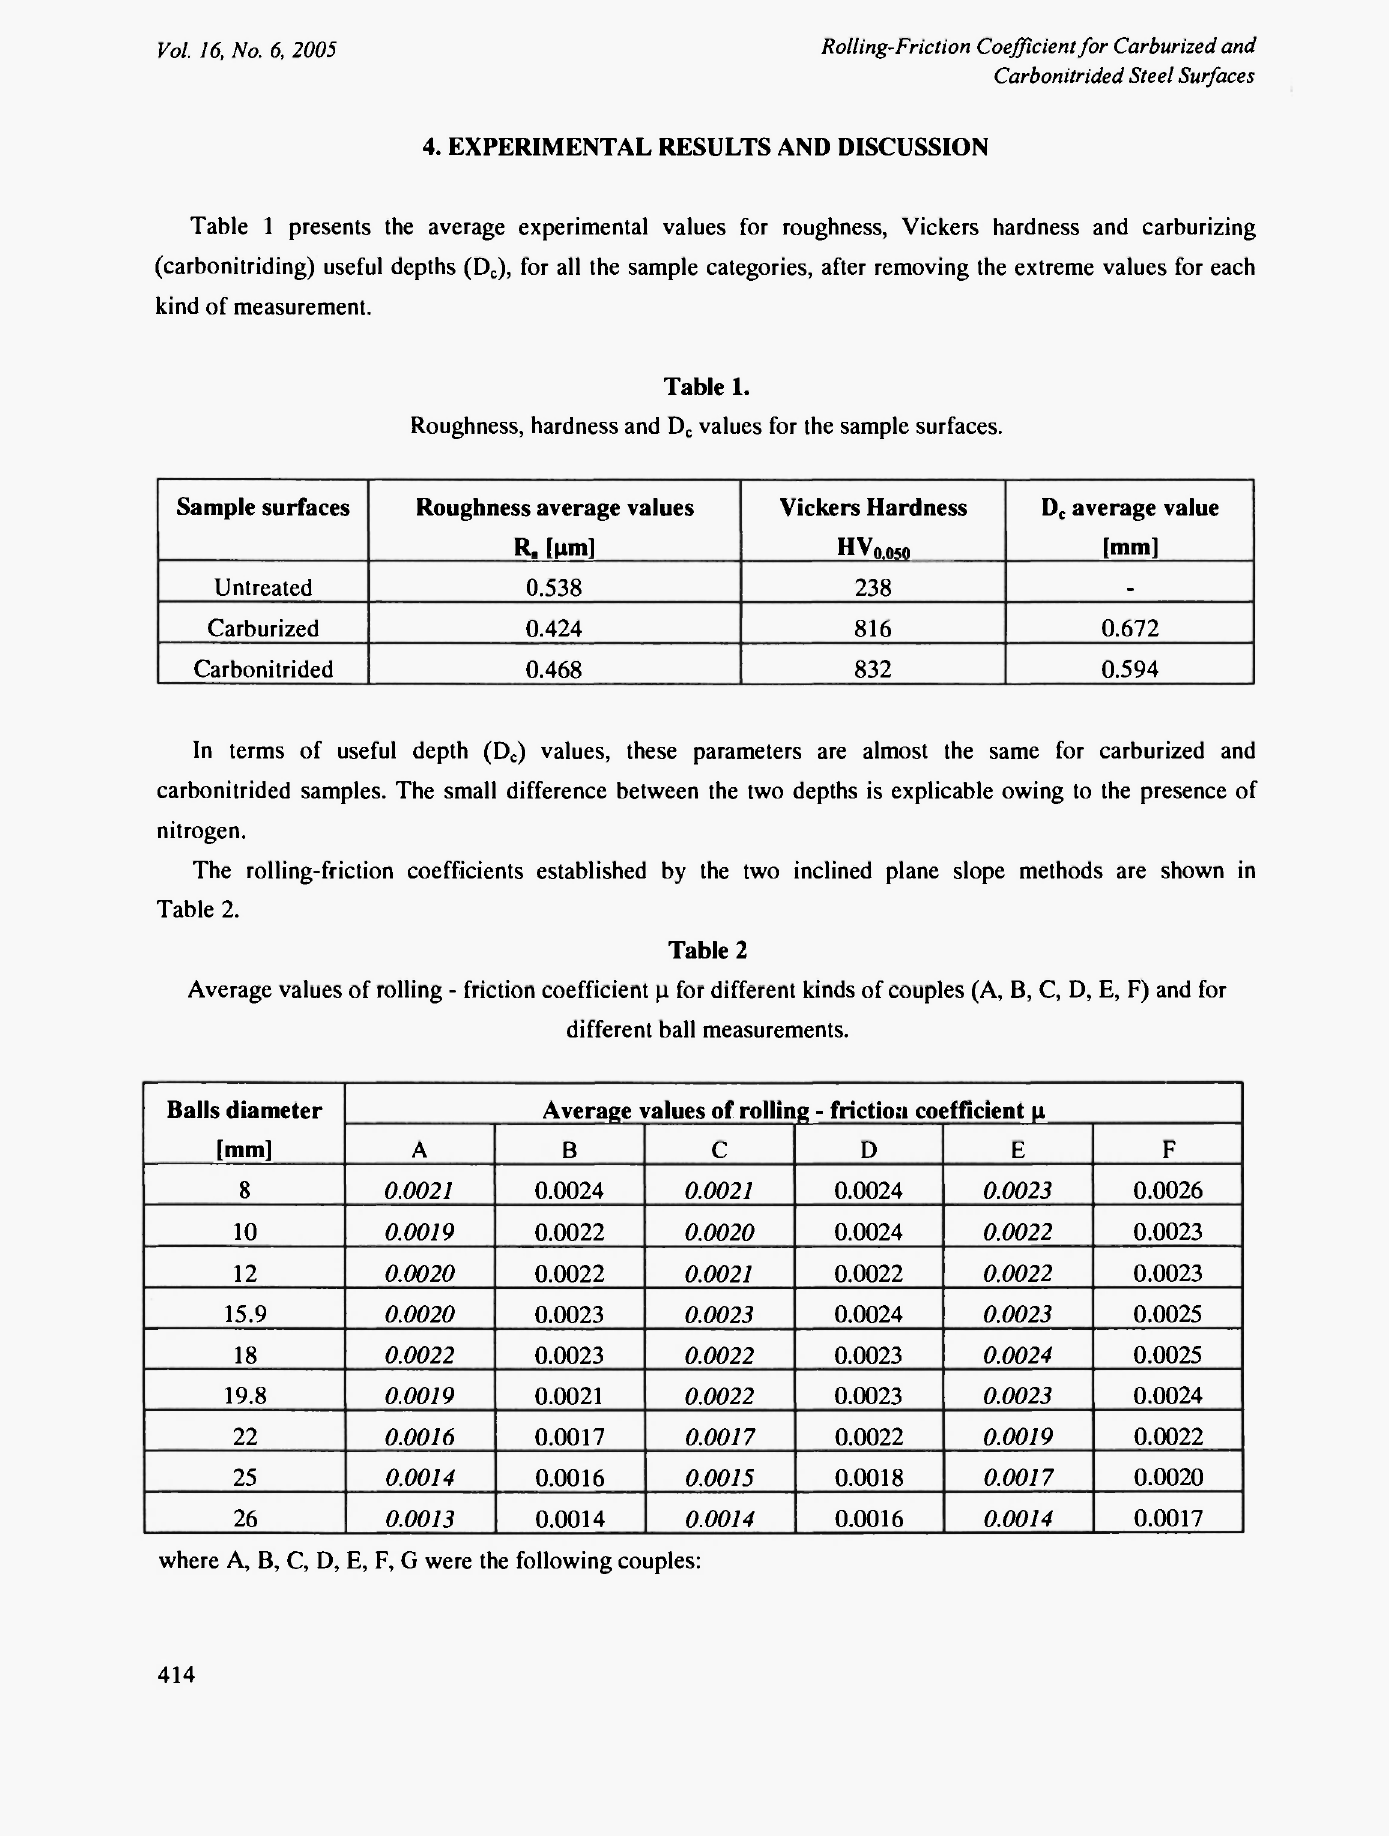
Roughness, hardness and D c values for the sample surfaces.